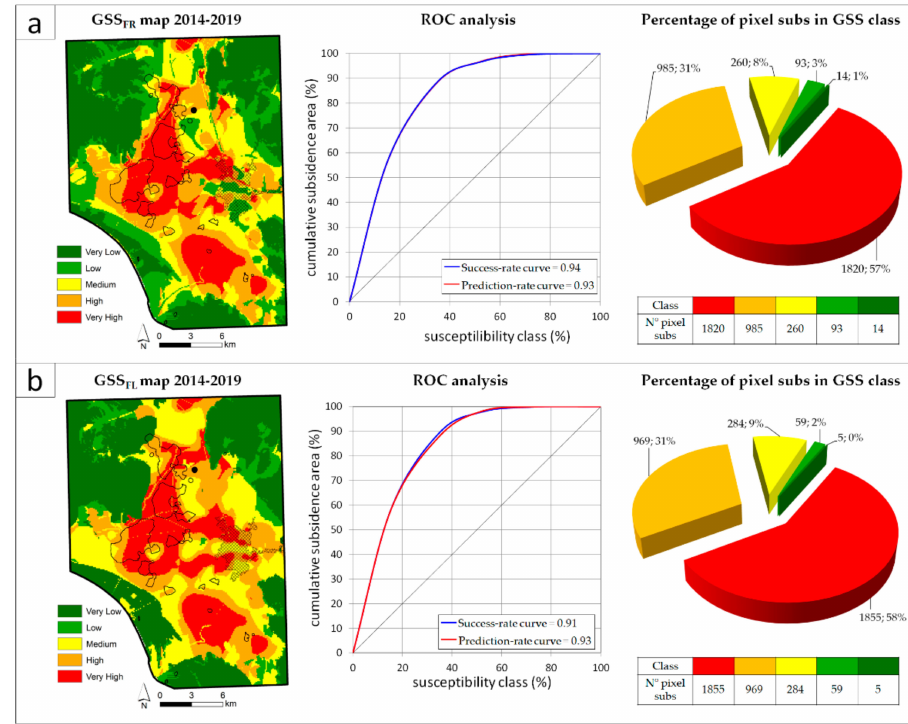
Figure 7. GSS maps output and validation results: ( a ) GSS FR map 2014–2019. The location of the Bottegone sinkhole in 1999, the Grosseto urban fabric and the 2014–2019 subsidence inventory are overlapped on the maps; ROC analysis of success-rate and prediction-rate curves; pie chart of percentages of pixel in subsidence falling into each susceptibility classes; ( b ) GSS FL map 2014–2019; ROC analysis of success-rate and prediction-rate curves; pie chart of percentages of pixel in subsidence falling into each susceptibility